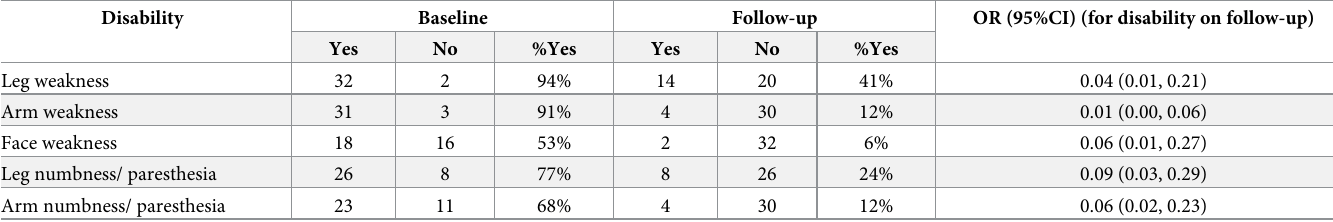
Table 3. Characteristics of neurological symptoms at onset and follow-up for confirmed GBS cases, Barranquilla, Colombia. Disability Baseline Leg weakness Arm weakness Face weakness Arm numbness/